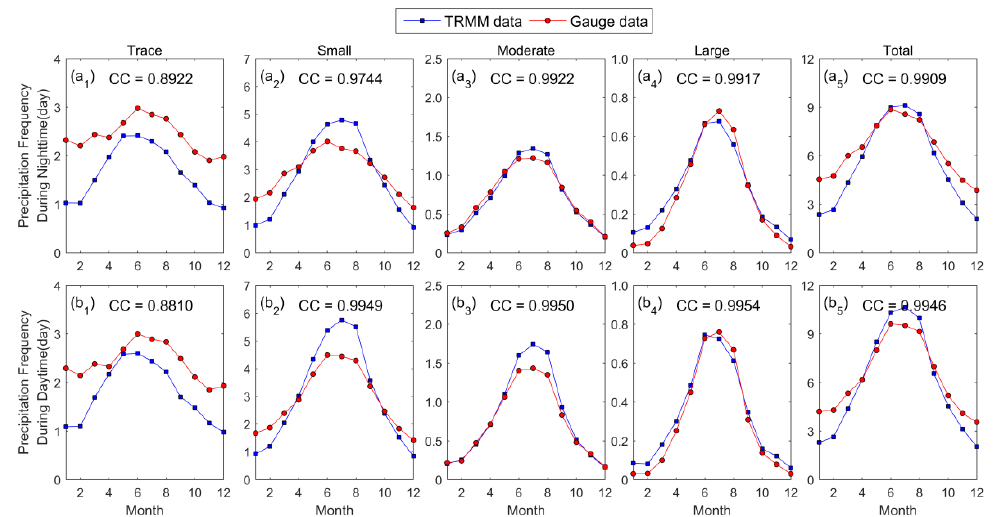
Figure 5. Seasonal cycle of multiyear mean precipitation frequencies from TRMM 3B42 data and gauge data for precipitation frequencies during the ( a ) nighttime and ( b ) daytime for various precipitation categories over mainland China. From left to right are days with a trace amount of rain ((0.1 ≤ P < 1 mm (12 h) − 1 )), a small amount of rain (1 ≤ P < 10 mm (12 h) − 1 ), a moderate amount of rain (10 ≤ P < 25 mm (12 h) − 1 ), a large amount of rain (P ≥ 25 mm (12 h) − 1 )); and total precipitation (P ≥ 0.1 mm (12 h) − 1 ). The y -axis scales are di ff erent for di ff erent precipitation